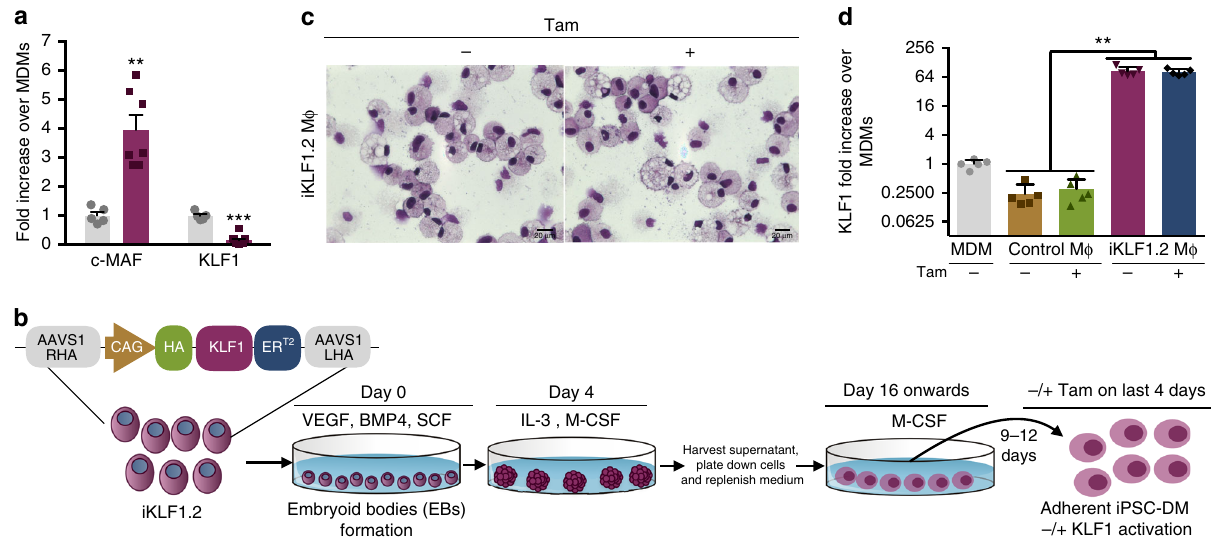
Fig. 1 AAVS1-targeted KLF1 transgene is expressed in iPSC-DMs. a Expression of ‘ EI ’ macrophage related transcription factors ( c-MAF and KLF1 ) in monocyte-derived macrophages (MDMs) (grey bar) and iPSC-derived macrophages (purple bar) by qRT-PCR analyses ( n = 5, Mann Whitney test). b Differentiation protocol used to generate macrophages from an iPSC line (iKLF1.2) carrying the AAVS1-targeted KLF1-ER T2 transgene. c Kwik-Diff-stained cytospin preparations of iKLF1.2-derived macrophages (iKLF1.2M Φ ) (scale bar, 20 μ m). d Real-time PCR analysis of KLF1 in MDMs , control iPSC-DMs (control M ϕ ) and iKLF1.2-DMs (iKLF1.2 M Φ ) ( n = 4 biologically independent samples) Kruskal – Wallis test with Dunn ’ s post-test). * p < 0.05, ** p < 0.01, *** p < 0.001, **** p <